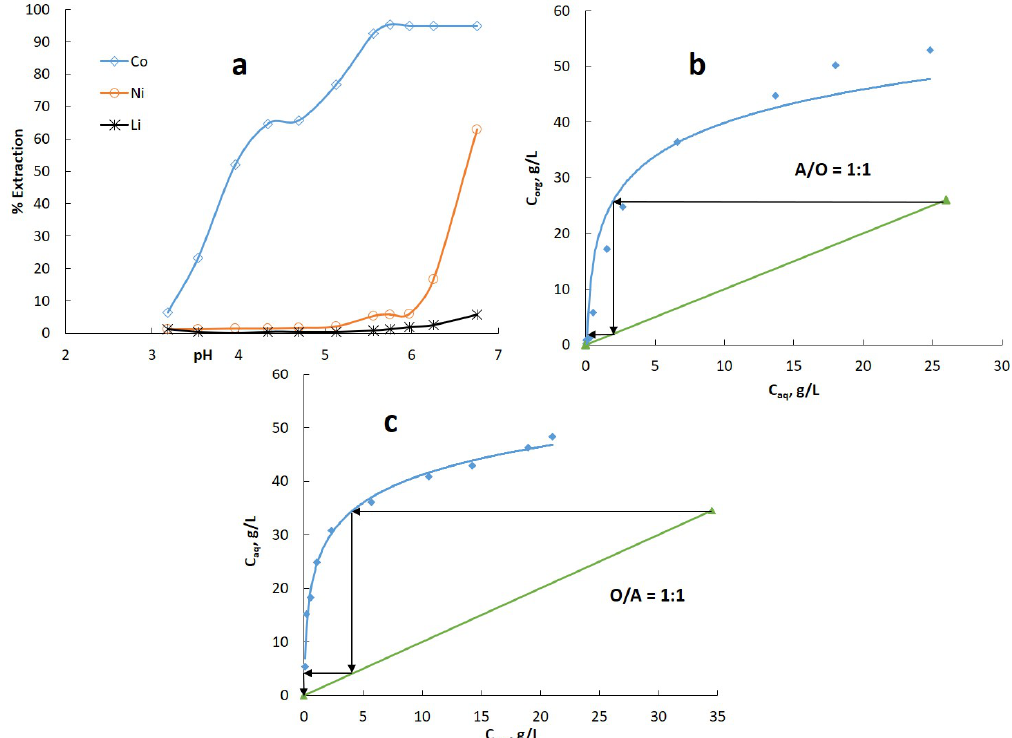
Figure 6. ( a ) pH isotherms for Li, Ni and Co extraction using 1 M Cyanex 272 (Exxsol ® D80 ™ ; 35 ◦ C); ( b ) Loading isotherm of Co into 1 M Cyanex 272 (Exxsol ® D80 ™ ; 35 ◦ C) and initial design using the McCabe-Thiele method; ( c ) Stripping of cobalt from loaded Cyanex 272 with 2 M H 2 SO 4 at 35 ◦